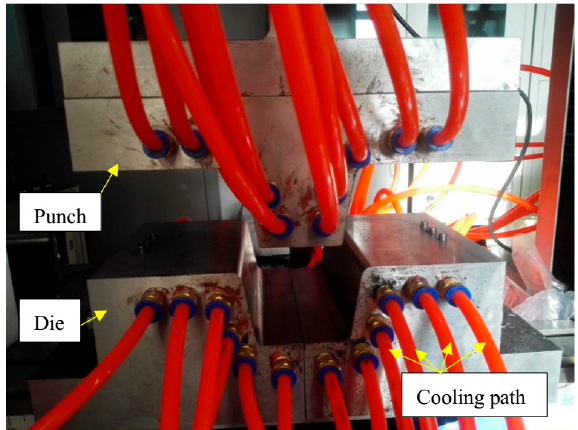
Figure 1. The mold of warm/hot stamping.